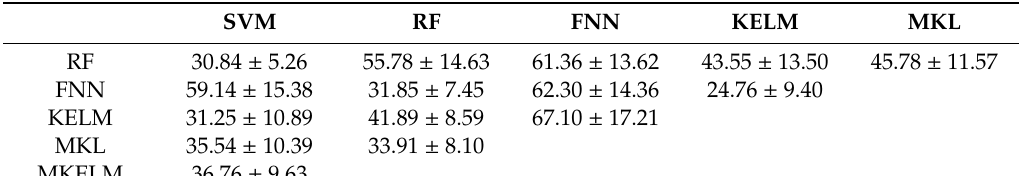
Table 6. Chi-square values from McNemar’s test performed on the six classification algorithms. A chi-square value ≥ 3.84 indicates a significant difference ( p < 0.05) between two classification results.